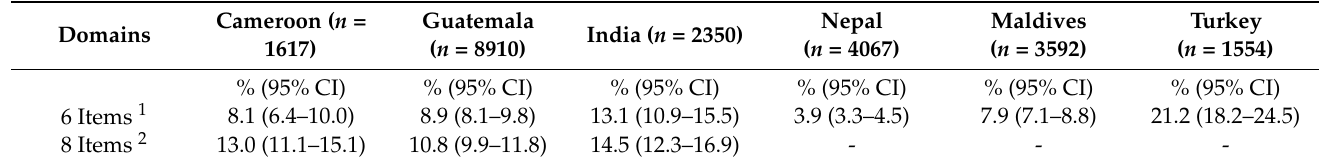
Table 5. Disability prevalence by alternative question sets—Standard